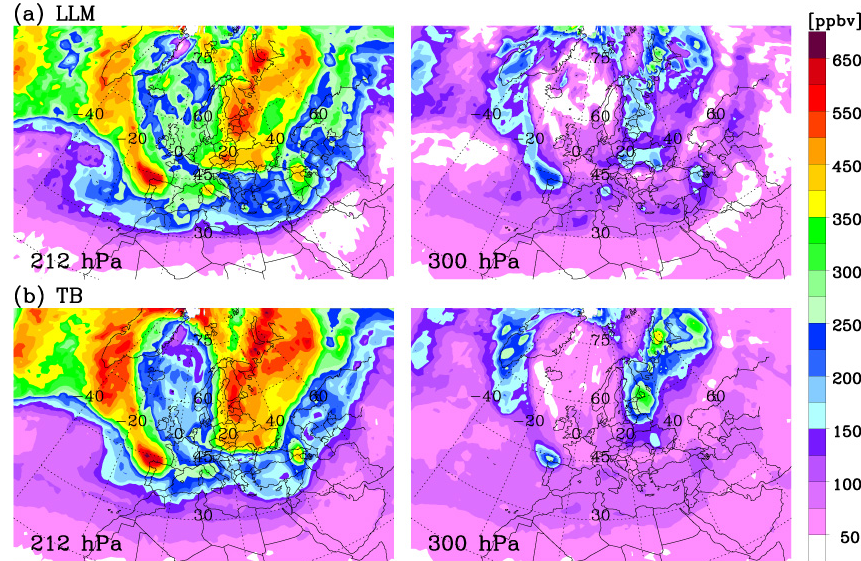
Fig. 5. Same as Fig. 4a and b, but for the OMI ozone